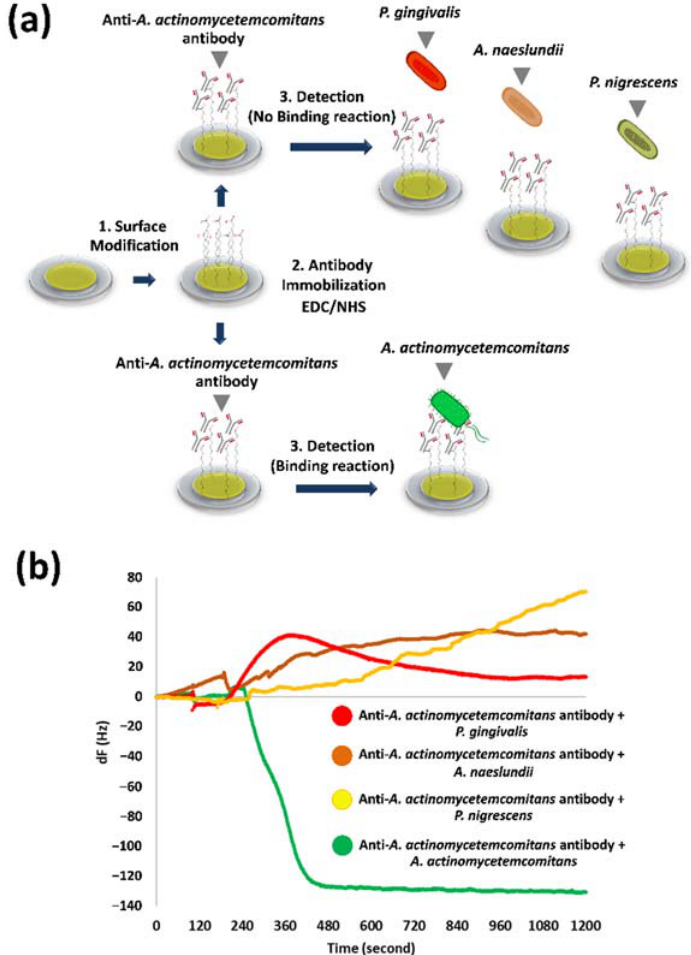
Figure 5. Selectivity of the modified QCM sensor. ( a ) The processes of the 11-MUA formation on a gold electrode in conjunction with immobilization of antibodies and binding reaction are schematically shown. ( b ) The representative response profile of A. actinomycetemcomitans antibody-immobilized sensors for A. actinomycetemcomitans (green line) detection is shown, while P. gingivalis (red line), P. nigrescens (yellow line) and A. naeslundii (brown line) were used as negative control.